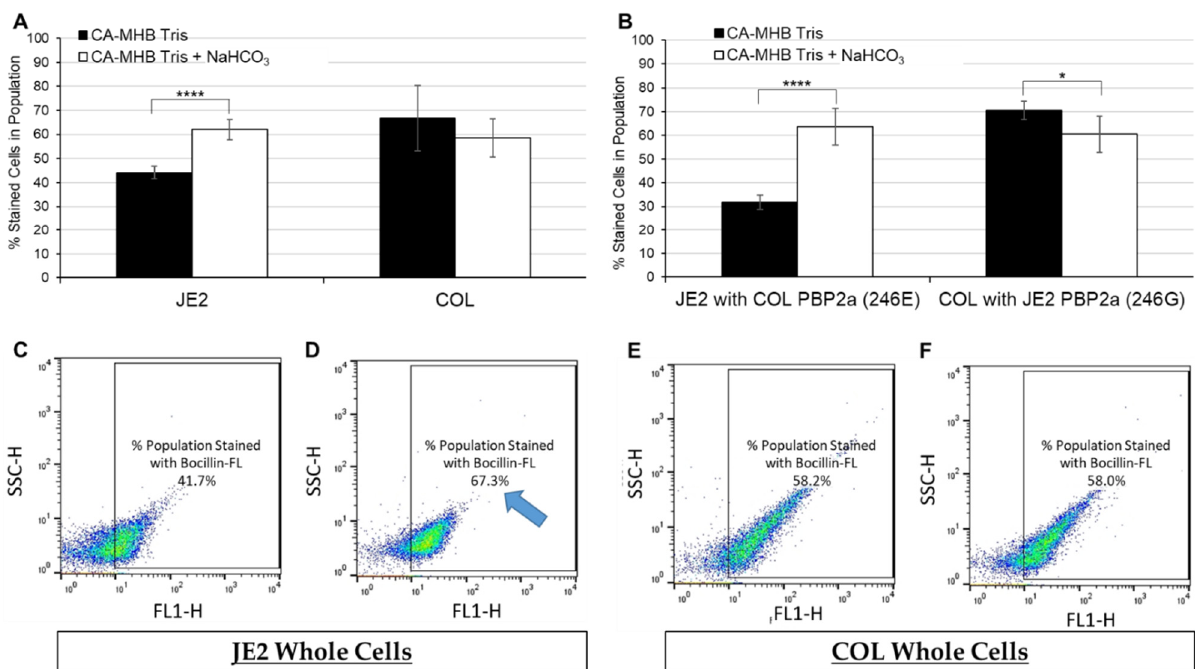
Figure 4. Percentage of JE2 and COL cells out of total population (10,000 cells) stained with Bocillin- FL following growth in cation-adjusted Mueller Hinton broth (CA-MHB Tris) ± 44 mM NaHCO 3 . ( A ) Summary of average Bocillin-FL binding for JE2 and COL. ( B ) Summary of average Bocillin-FL binding for JE2 and COL strains with “swapped” mecA coding regions. ( C – F ) Representative dot-plots for ( C ) JE2 grown in CA-MHB Tris ( D ) + NaHCO 3 , vs. COL grown in ( E ) CA-MHB Tris ( F ) + NaHCO 3 . Gates on dot-plots (box surrounding cells) depict percentage of cells in total population of 10,000 cells that have taken up the Bocillin-FL dye. Note enhanced proportion of JE2 cells stained with Bocillin-FL in the presence vs. absence of NaHCO 3 (blue arrow). Statistics were calculated by a Student’s t -test, * p < 0.05, **** p < 0.0001.